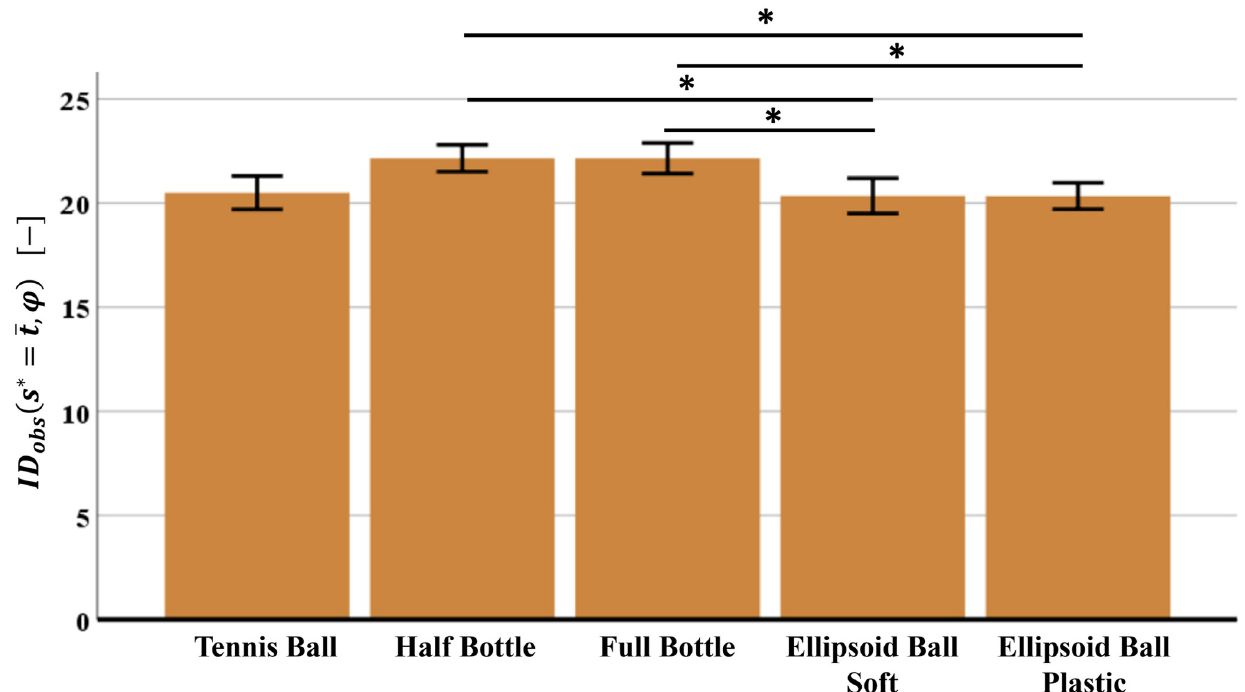
(cid:0) � , evaluated for the entire manipulation s � ¼ � t � ; φ obs